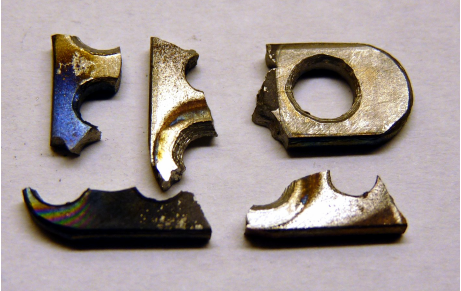
Figure 10. Disintegrated cathodes after embrittle- ment by a hydrogen diffusion into